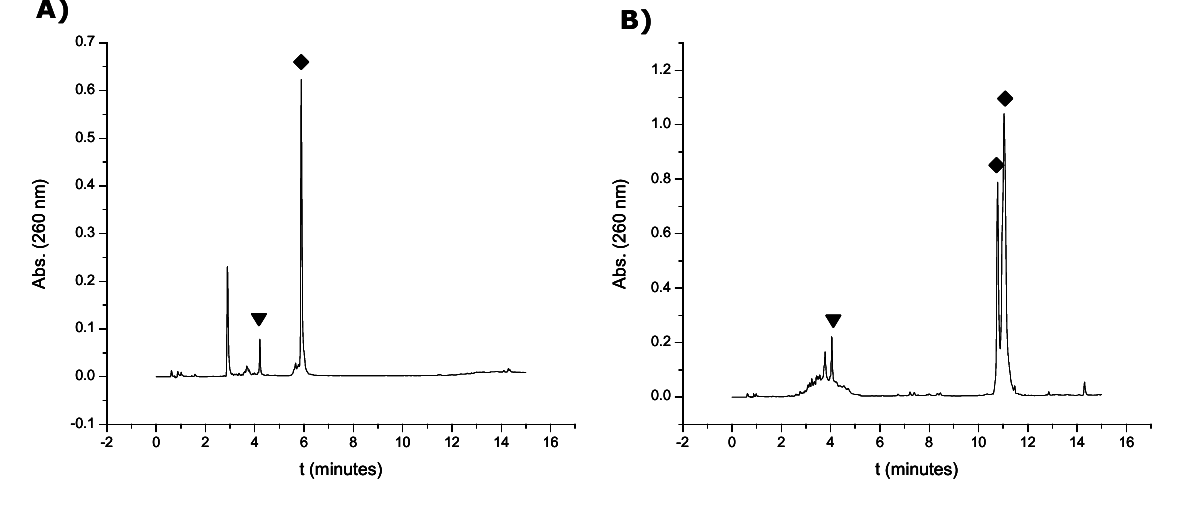
Figure 2. HPLC profiles of the mixtures obtained after the reaction of oligonucleotide 15 with ( A ) 2-bromo-2'-hydroxy-5'-nitroacetaniline to yield compound 16 and ( B ) with N -(1-pyrenyl)maleimide to yield compound 17 ( ▼ stands for the thiol oligonucleotide 15 and ♦ stands for the resulting oligonucleotide